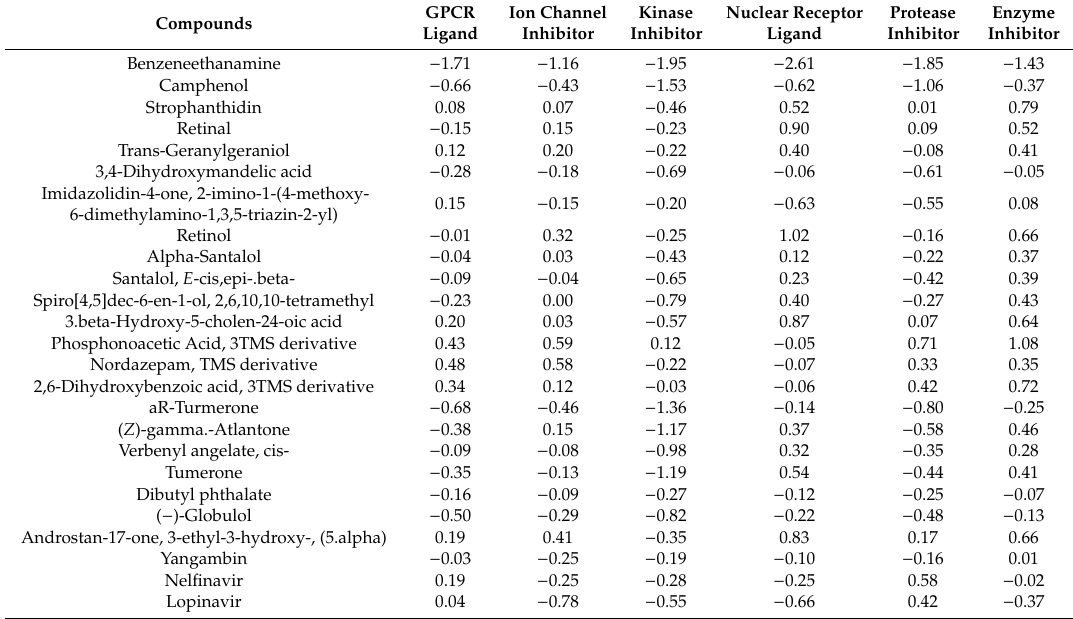
Table 4. Biological activity prediction of methanol extract of T.